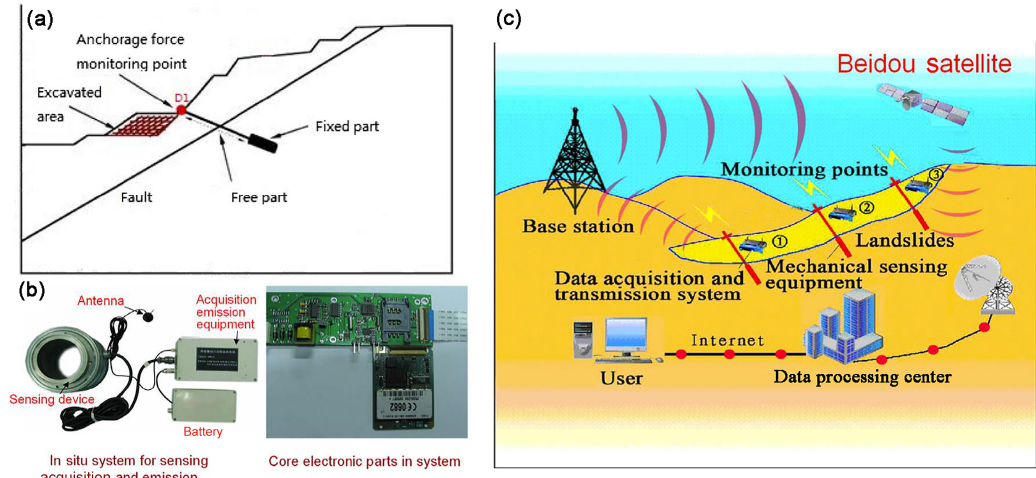
Figure 1. Remote-sensing system for monitoring and predicting landslides: (a) simplified model of the CRLD cable sliding-resistant system, (b) remote-sensing equipment, and (c) Beidou satellite remote-sensing system for monitoring the anchorage force (Li et al.,